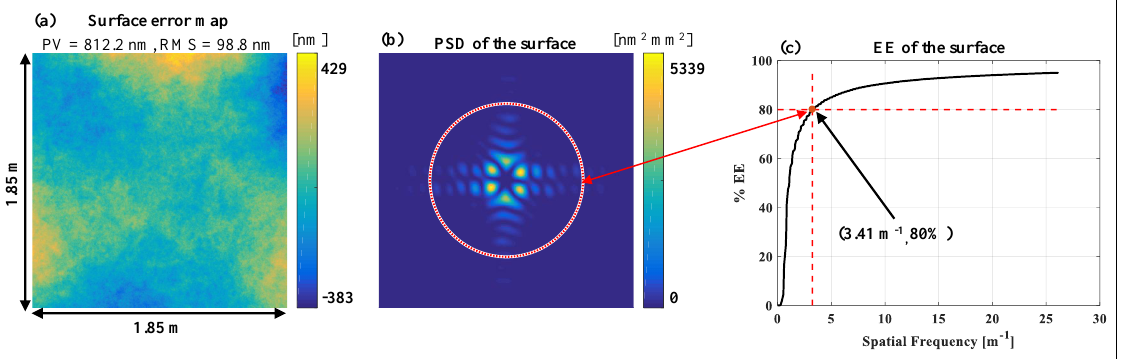
Figure 2. An example surface error map ( a ) and its 2D PSD map ( b ). The EE of the PSD ( c ) demon- strates that 80% of the RMS error was due to spatial frequencies lower than 3.41 m − 1